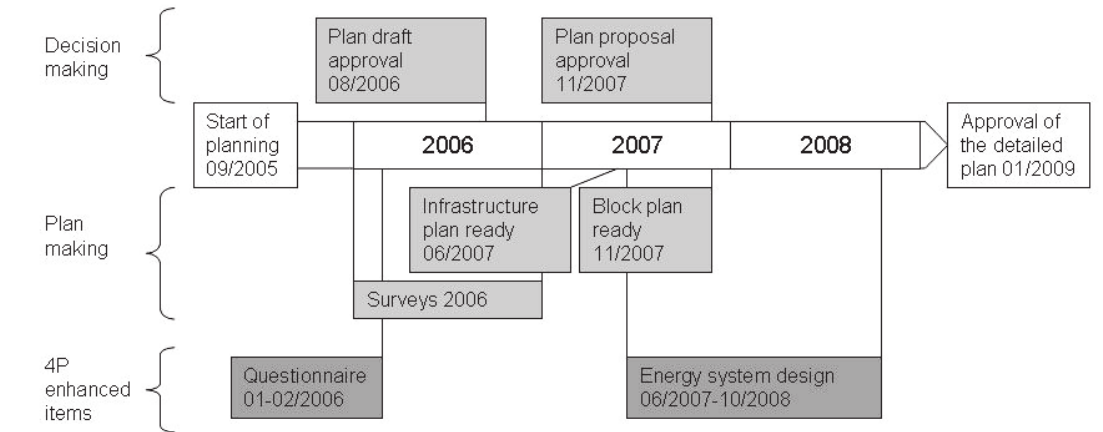
Figure 2. timeline of formal decision making and 4P planning process in